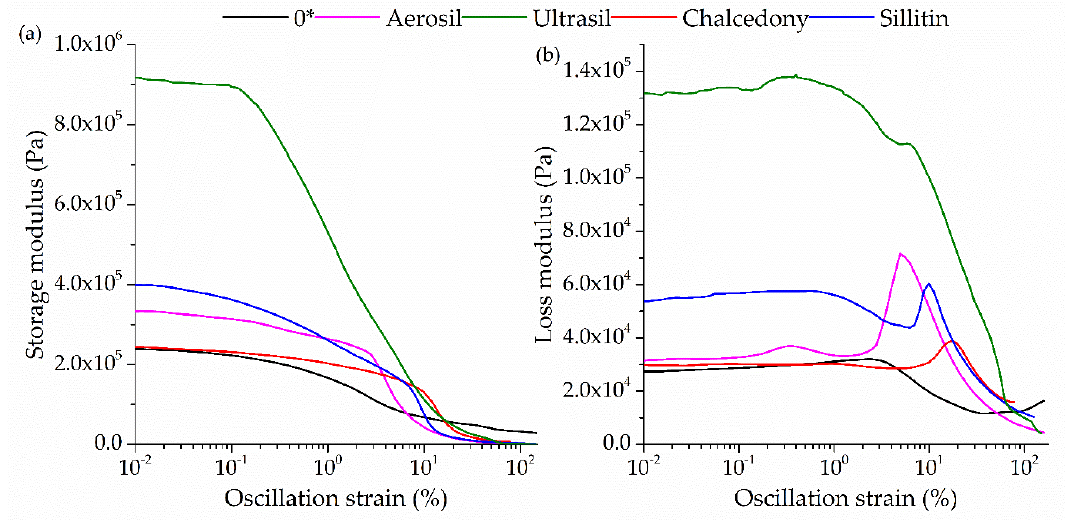
Figure 1. Storage modulus ( a ) and loss modulus ( b ) of unfilled and filled CR/BR/nano-Fe 2 O 3 vulcanizates.